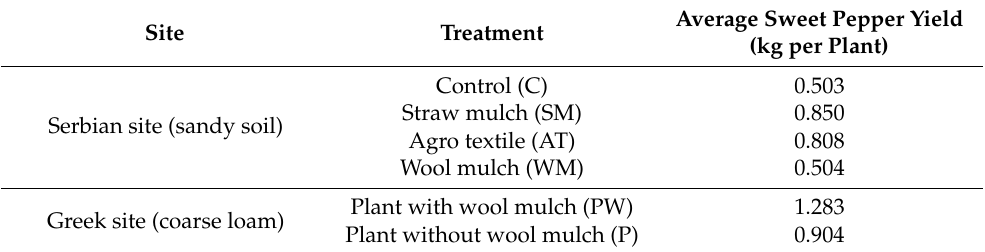
Figure 2. Soil temperature ( ◦ C) plotted as a function of treatments at different times at the site in Greece. In addition to the group averages (circles), 95% confidence intervals are given for each group based on the combination of treatment and time. Table 3. The effect of treatments on average pepper yield per plant at the Serbian and Greek sites.